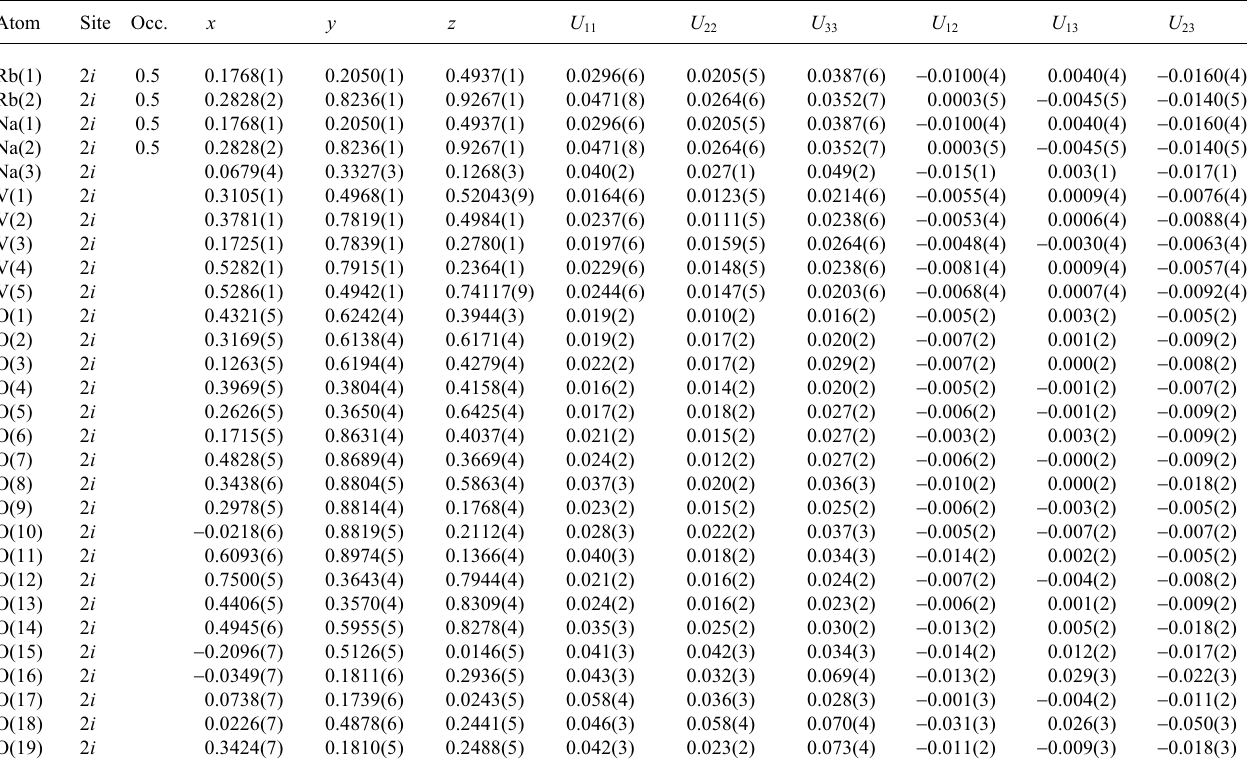
Table 3. Atomic coordinates and displacement parameters (in Å 2 ) . Atom Site